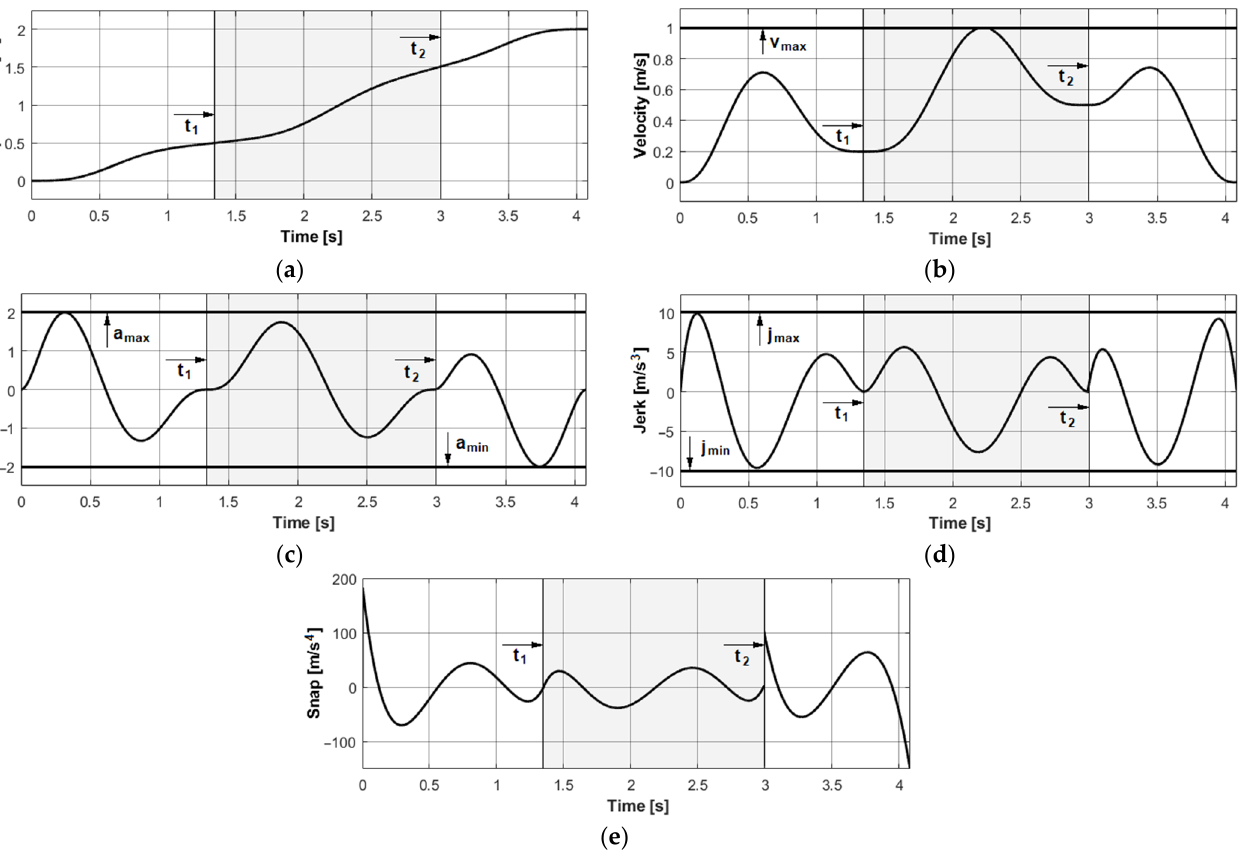
Figure 5. Profiles of kinematic quantities for the assumed trajectory with the intermediate points: ( a ) displacement, ( b ) velocity, ( c ) acceleration, ( d ) jerk, ( e )